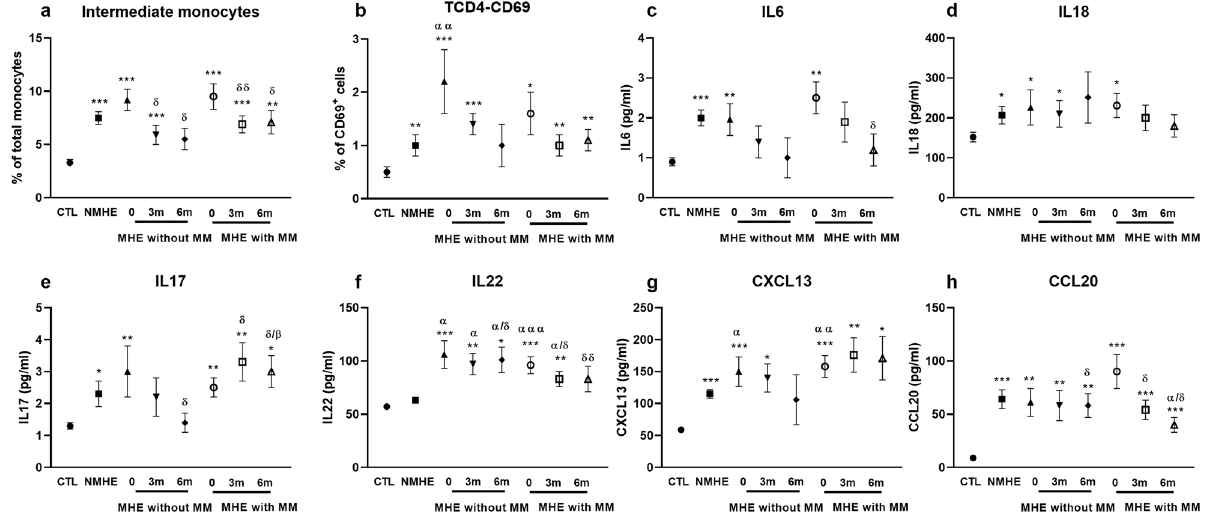
Figure 3. Inflammatory parameters at baseline and at 3 and 6 months of rifaximin treatment according to metabolic syndrome manifestations. *significant differences from controls (* p < 0.05; ** p < 0.01; *** p < 0.001). α significant differences from no MHE ( α p < 0.05; αα p < 0.01; ααα p < 0.001). β Significant differences from patients without metabolic syndrome manifestations ( β p < 0.05; ββ p < 0.01; βββ p < 0.001). ∂ significant differences from baseline ( ∂ p < 0.05; ∂∂ p < 0.01; ∂∂∂ p < 0.001). Abbreviations: CTL: controls; MHE and NMHE: patients with or without minimal hepatic encephalopathy, respectively; MM: metabolic syndrome